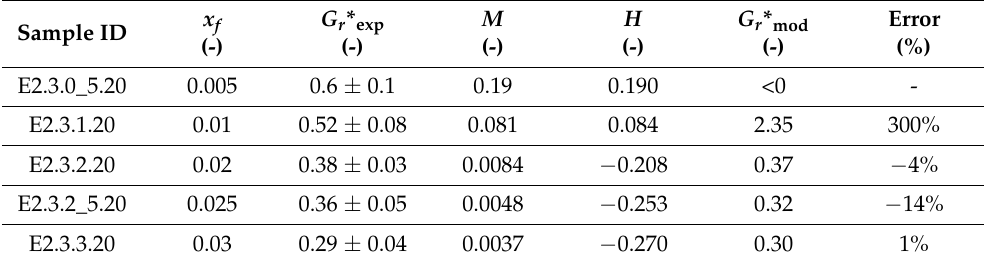
Table 6. Comparison between experimental ( G r * exp ) and model ( G r * mod ) values of the complex modulus for samples at different fiber contents ( x f ) prepared at E s = 45.2 J/g and P s = 0.151 W/g. Sample E2.3.3.20 was used in fitting parameter determination.